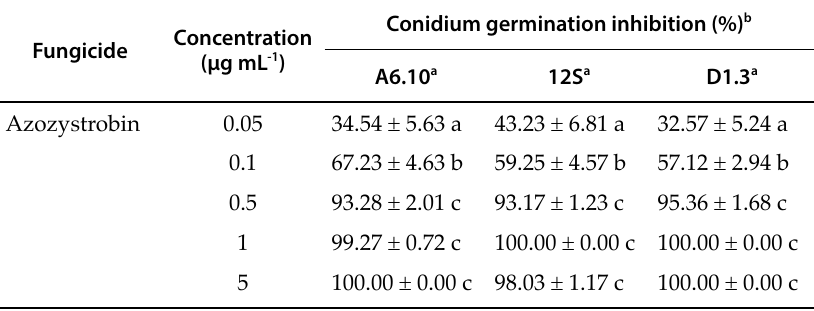
Table 3. Mean inhibition proportions (%, ± standard errors) of conidium germination for three toxigenic strains of Aspergil- lus flavus , resulting from treatments with different concentrations of